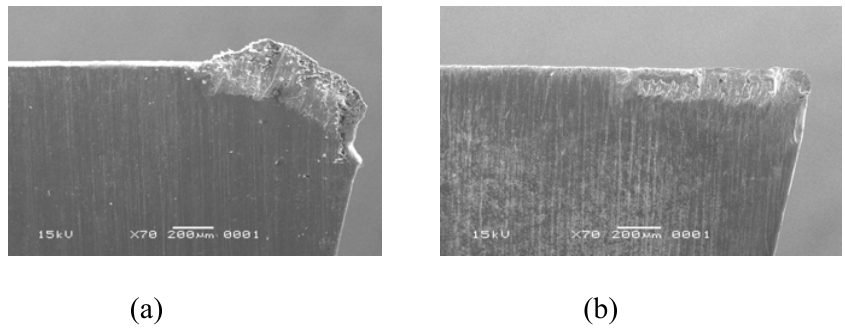
= 41.12 m min -1 ): (a) CrN and (b) c